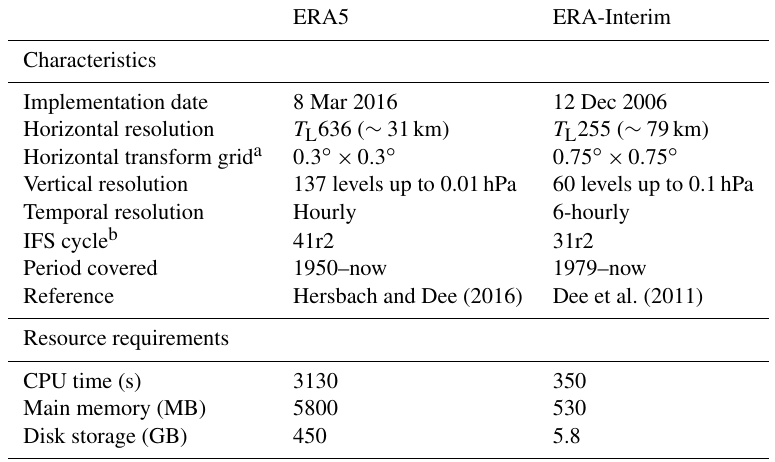
Table 1. Characteristics of the ERA5 and ERA-Interim reanalyses as well as resource requirements to calculate 10-day forward trajectories for 10 6 particles with the MPTRAC model on a single computing node (including 24 cores) of the JURECA supercomputer at